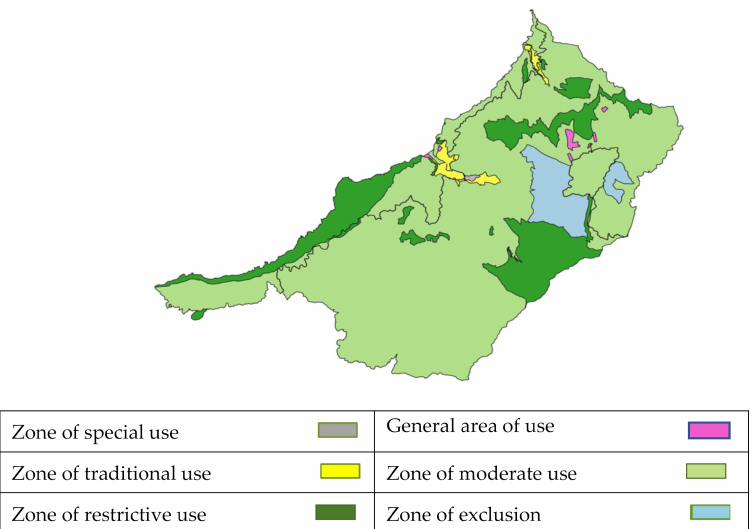
Figure 4. Tamadaba Natural Park zoning. Source: Government of the Island of Gran Canaria